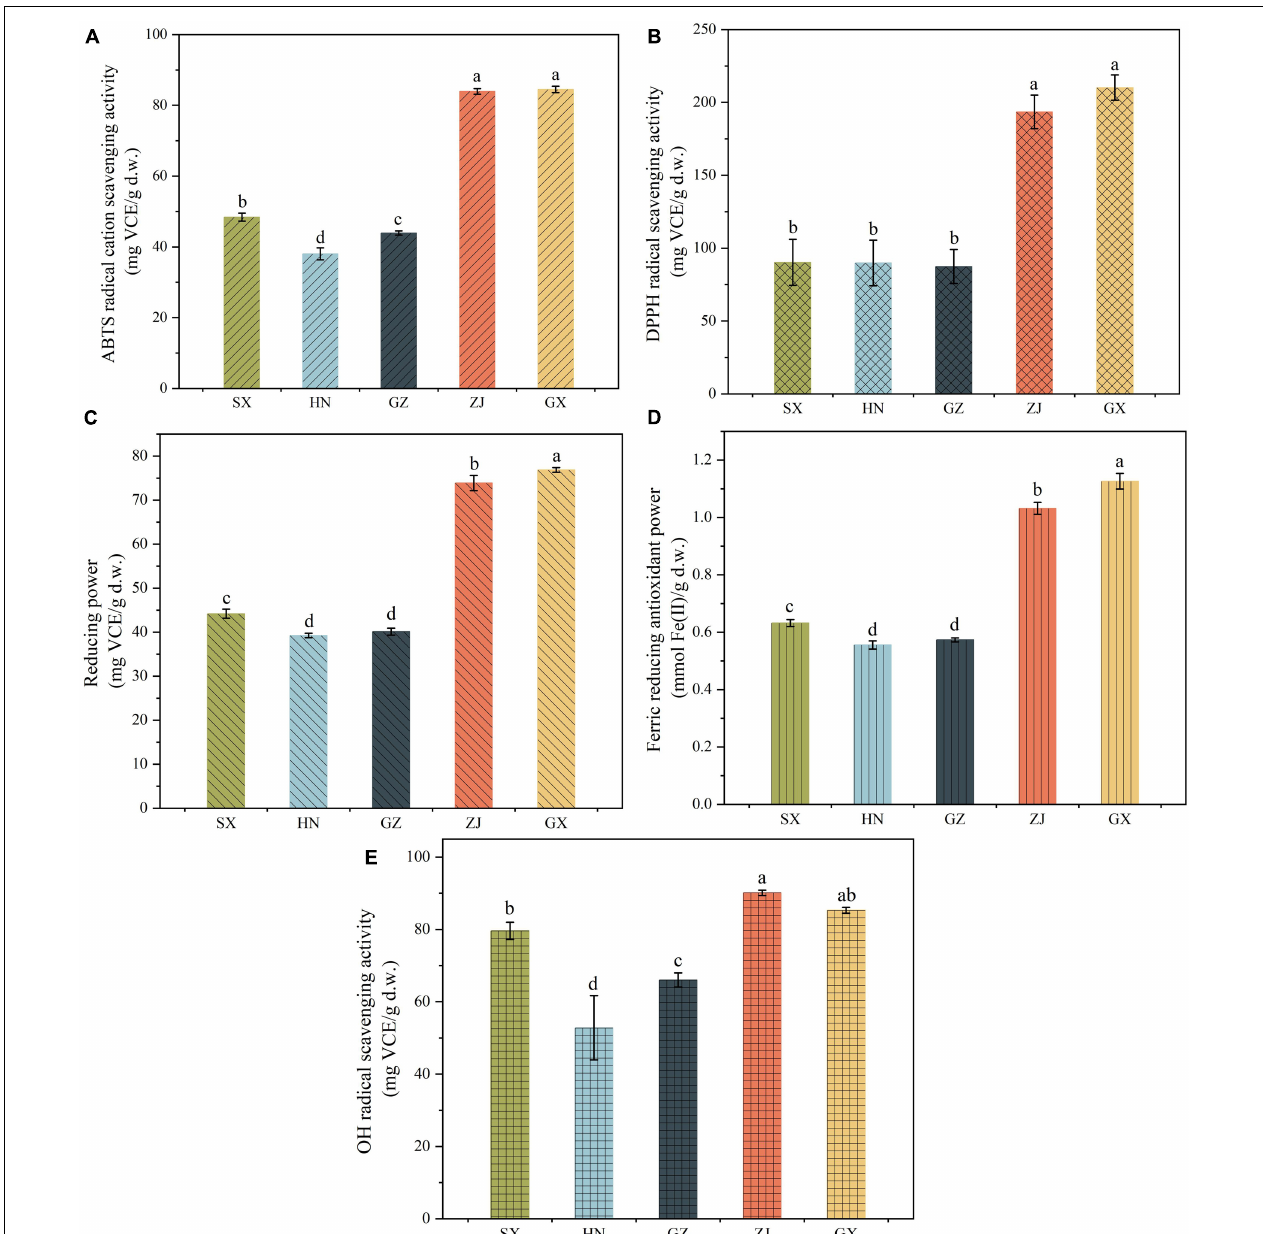
FIGURE 7 | Antioxidant activity of five Fu brick teas in different regions. ABTS radical cation scavenging activity (A) , DPPH radical scavenging activity (B) , reducing power (C) , OH radical scavenging ability (D) and ferric reducing antioxidant power (E) . Data were recorded as the mean value ± standard deviation of three replicates. Mean values marked by the different letters among the samples denoted significant difference ( p <